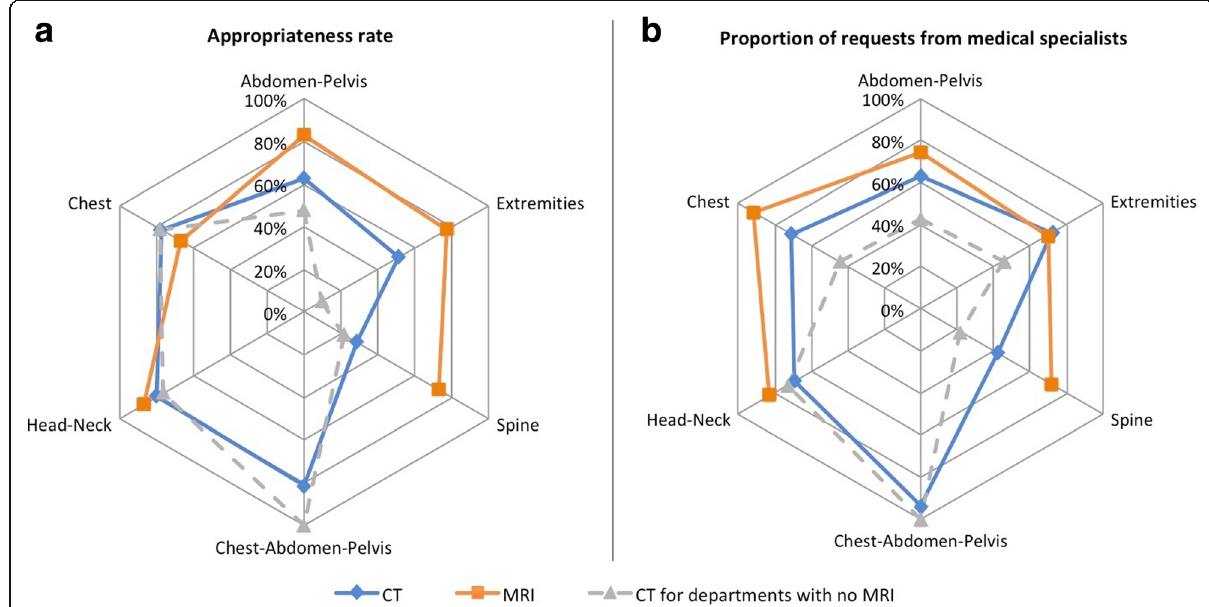
Fig. 2 a Radar chart showing AR for each anatomical area for CT requests, MRI requests and CT requests for the two radiology departments not equipped with MRI units. b Radar chart showing for each anatomical area the proportion of requests from medical specialists depending on each anatomical area for CT request, MRI requests, and for CT requests for the two radiology departments not equipped with MRI